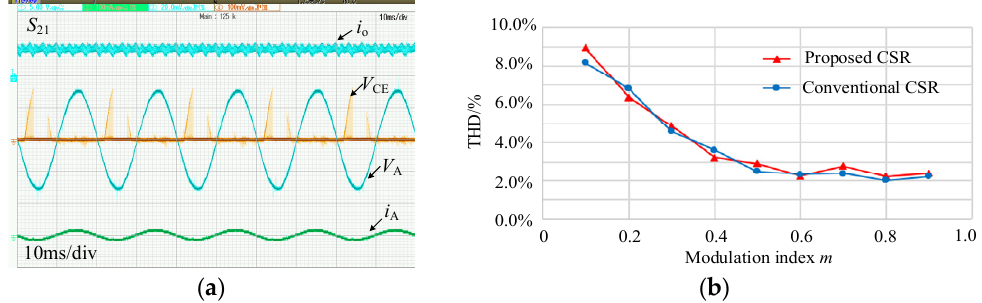
Figure 14. Experimental waveforms under unity power factor: input phase voltage V A (50 V/div), input phase current i A (10 A/div), output current i o (2 A/div), and measured voltage stress V CE (50 V/div). ( a ) Voltage stress. ( b ) Total harmonic distortion (THD) of input current.